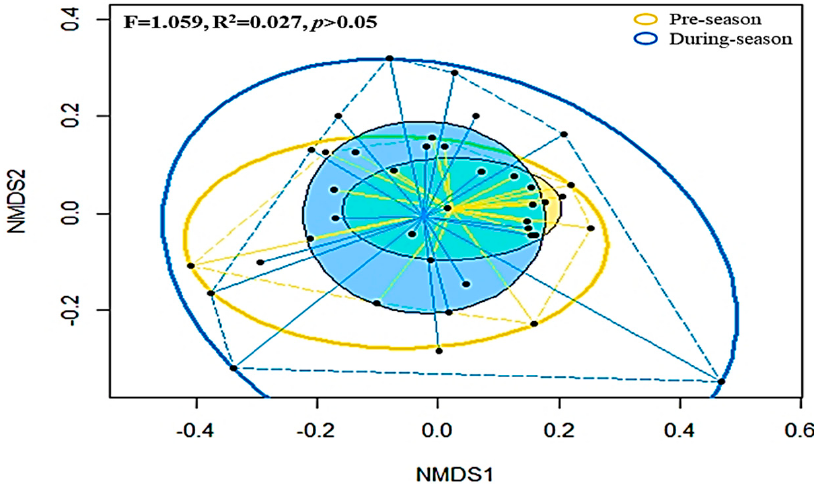
Figure 5. Non-metric multidimensional scaling (NMDS) based on Bray–Cutis distance matrix enclosing all 40 datasets. Black dots represent individual soil bacterial community; Solid lines represent ellipses enclosing all points in different groups; Dashed lines represent convex hulls by ordihull function.